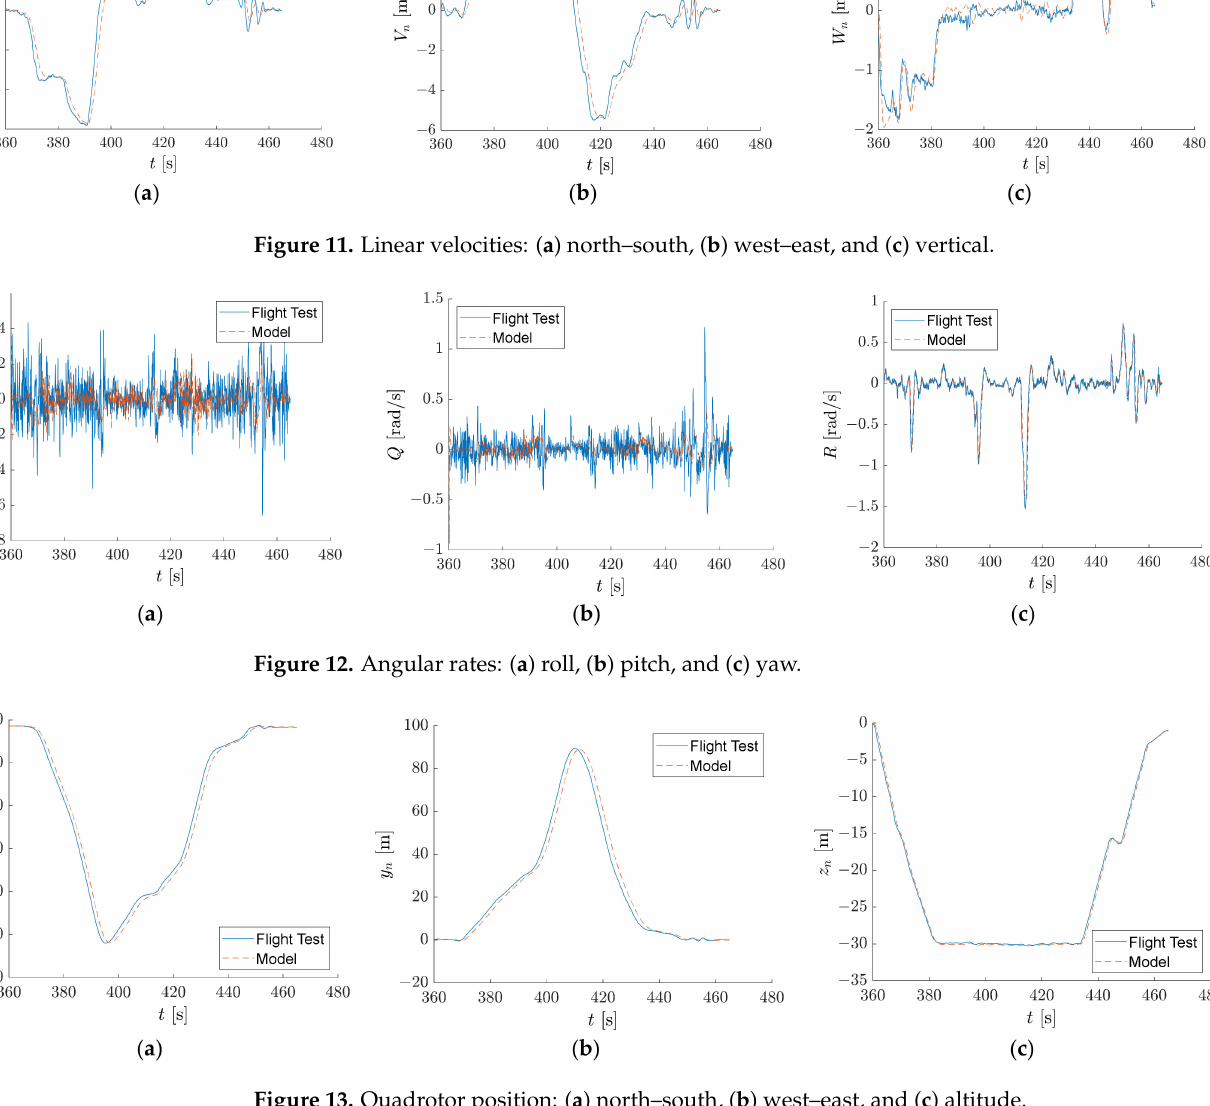
Figure 13. Quadrotor position: ( a ) north–south, ( b ) west–east, and ( c )